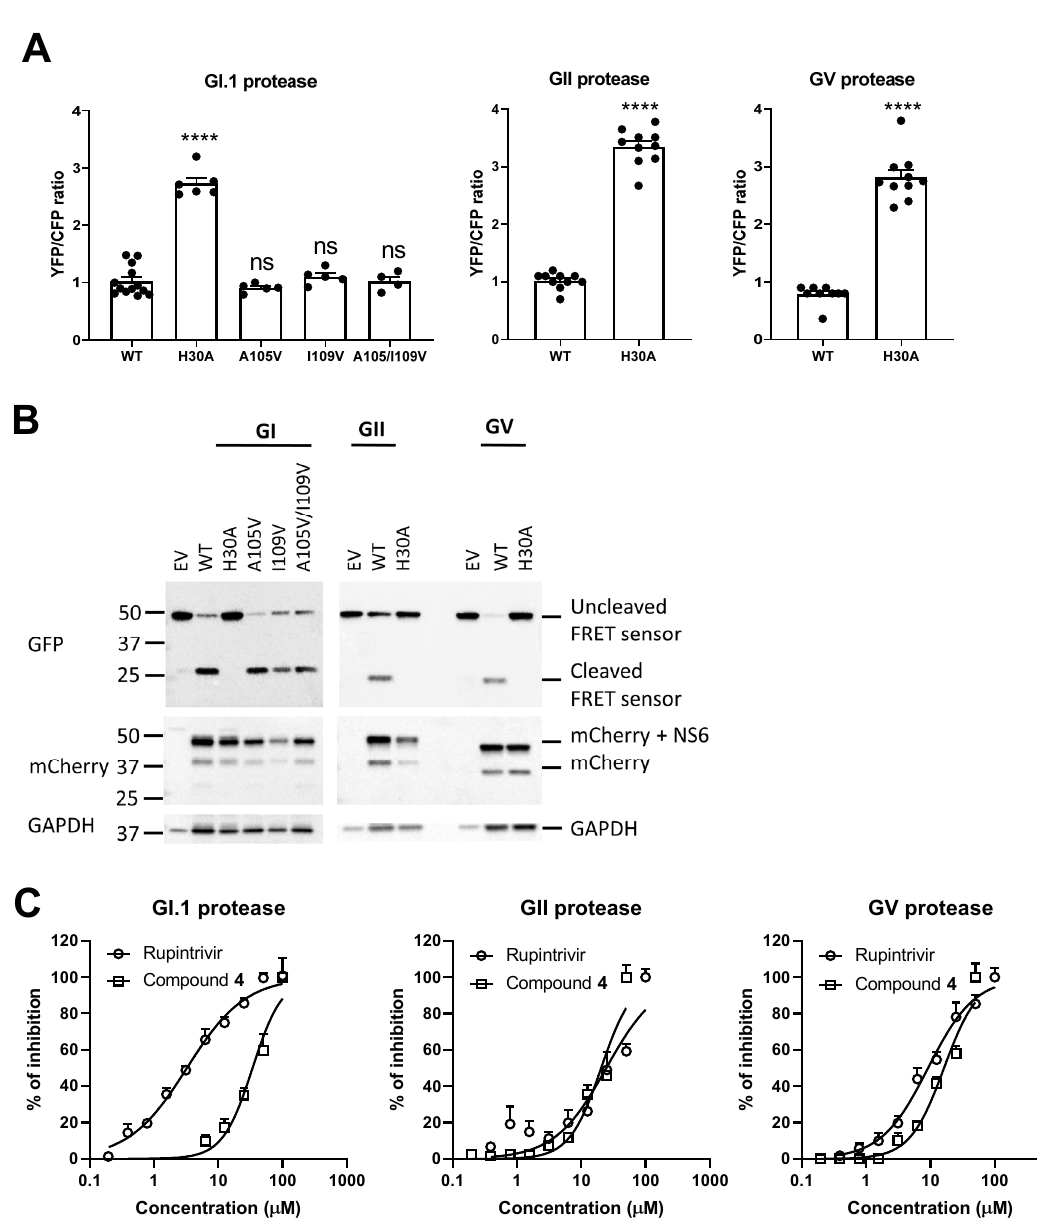
Figure 3. Compound 4 and rupintrivir block the norovirus protease. ( A ) The FRET signal was lost upon co-transfection with the wild-type (WT) or a mutated protease (A105V, I109V, A105V/I109V). The signal remained upon co-transfection with the inactive (H30A) protease. ( B ) Western blot of HEK293T cells co-transfected with the GI, GII or GV WT or mutant proteases along with the FRET construct. Cleavage was observed in the WT and mutant proteases in all genogroups. EV: empty vector. ( C ) Dose–response curves of compound 4 and rupintrivir on the WT proteases. Mean values ± SEM are presented, Mann–Whitney test **** p < 0.0001, ns: not significant.